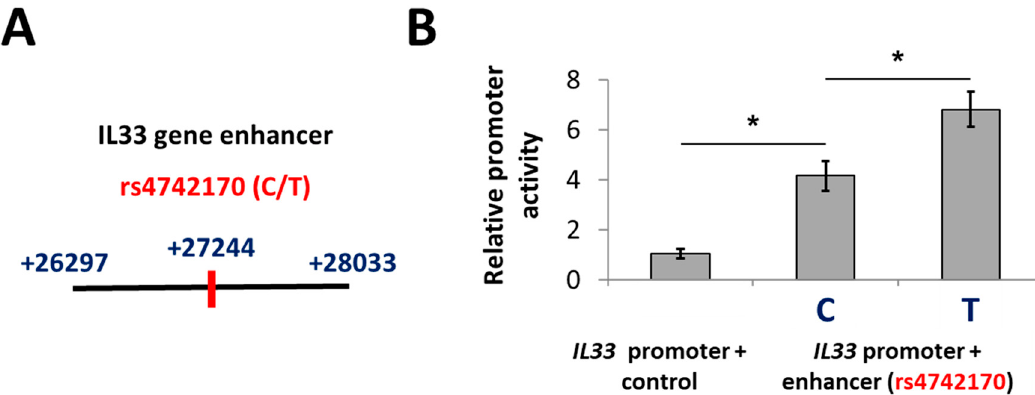
Figure 1. Predicted enhancer including rs4742170 induces IL33 promoter activity in a luciferase reporter system. ( A ) Schematic illustration of rs4742170 location in IL33 enhancer. ( B ) IL33 enhancer containing rs4742170 (T) allele stimulated IL33 promoter activity in lung cancer cells stronger than the rs4742170 (C) variant. The experiment was performed for five times. Relative promoter activities were calculated by normalization of Firefly luciferase signals to Renilla luciferase activities with further normalization to “ IL33 promoter + control” signal. * p < 0.01.